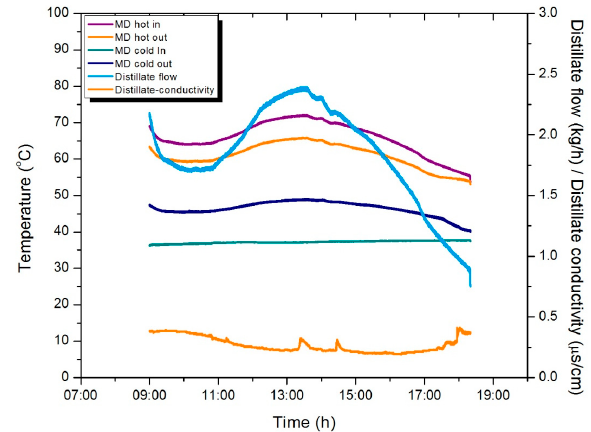
Figure 9. AGMD dynamic behavior during experiments on peak summer day.